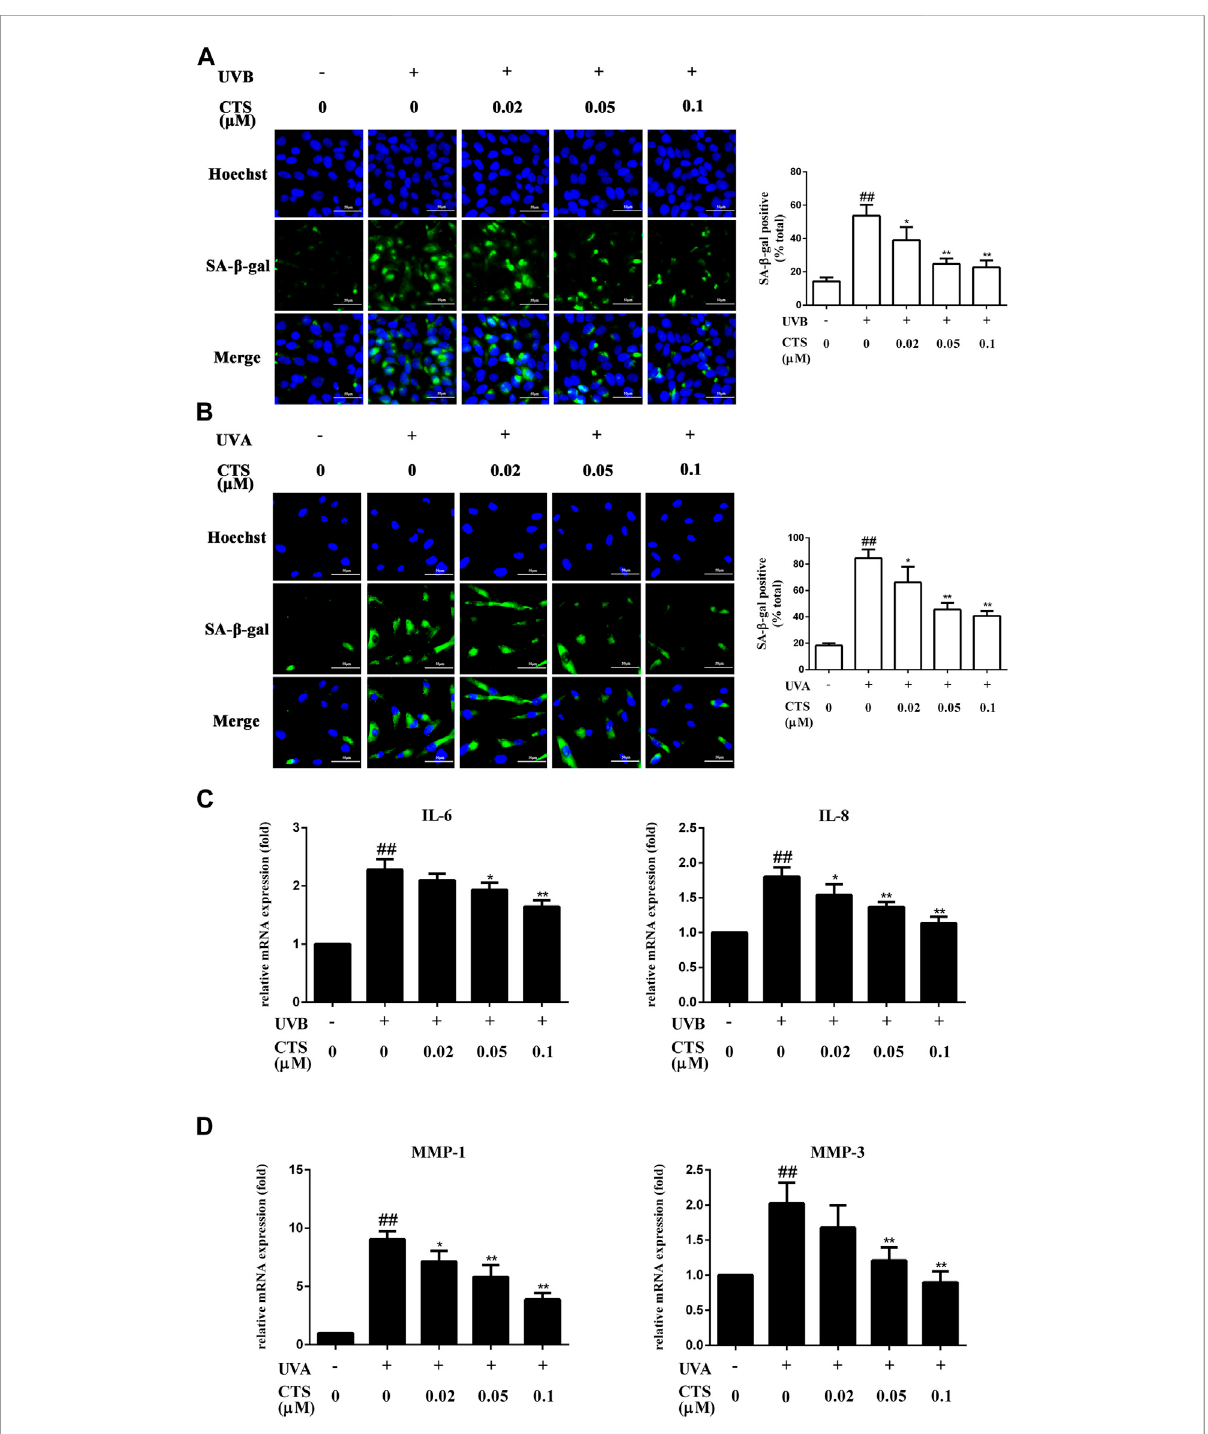
FIGURE 1 Effects ofCTSon UVradiation-inducedsenescenceinHaCaT cellsandHFF-1cells. HaCaTcells andHFF-1 cellsweretreated withCTS (0,0.02, 0.05, 0.1 μ M) for 12 h and then irradiated with UVB (200 mJ/cm 2 ) and UVA (15 J/cm 2 ), respectively. After that, the cells were cultured with fresh medium supplemented with the corresponding concentrations of CTS (0, 0.02, 0.05, and 0.1 μ M) for another 12 h in the case of HaCaT cells before analysis, and 24 h for HFF-1 cells. (A) SA- β -gal-positive HaCaT cells as measured by fl uorescence staining after 12-h of incubation following UVBirradiation.Theplotbesidesthe fl uorescenceimageshowsthenumberofsenescentHaCaTcells.Scalebars:50 μ m. (B) SA- β -gal-positiveHFF- 1 cells as measured by fl uorescence staining after 24-h of incubation following UVA irradiation. The plot besides the fl uorescence image counts the numberofsenescentHFF-1cells.Scalebars:50 μ m. (C)